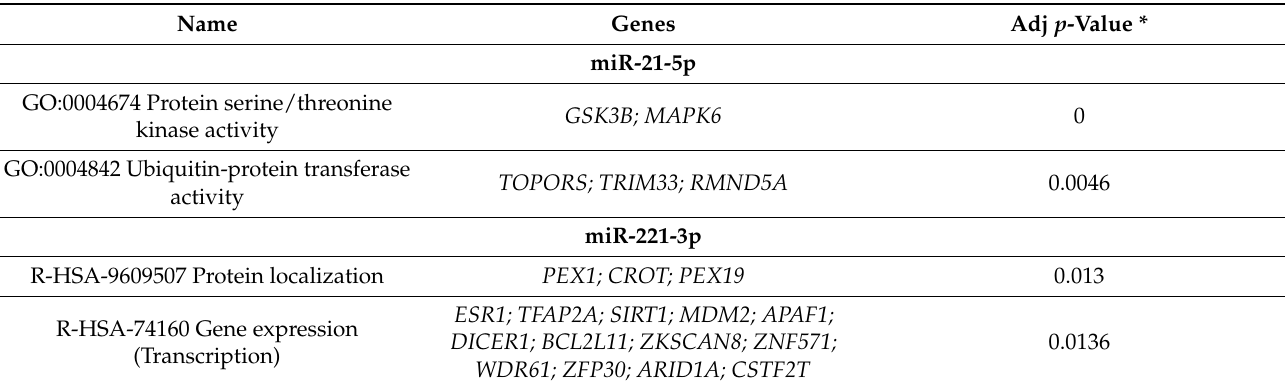
Table 5. Candidate miRNAs target genes and